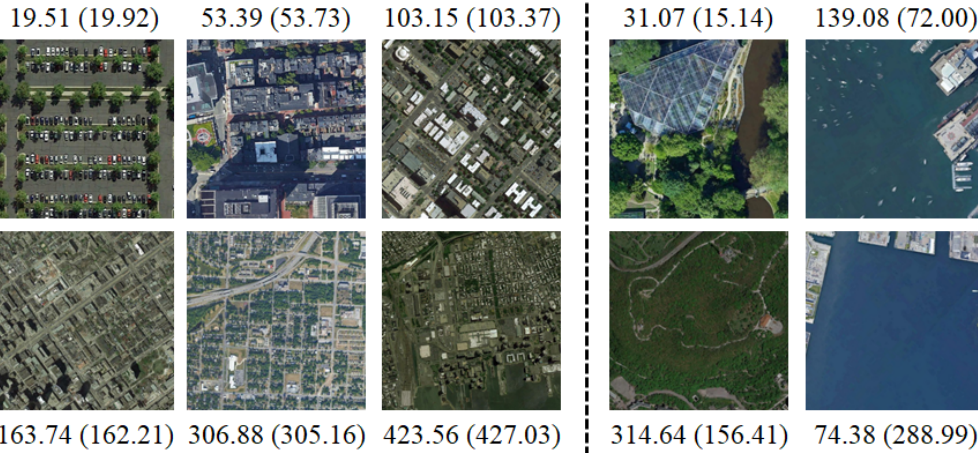
Figure 7. GSD prediction results of log GSD scale dataset 1 (rescaled single dataset) with the image size of 512. The number represents the GSD prediction, whereas the number in the parentheses indicates the ground truth GSD